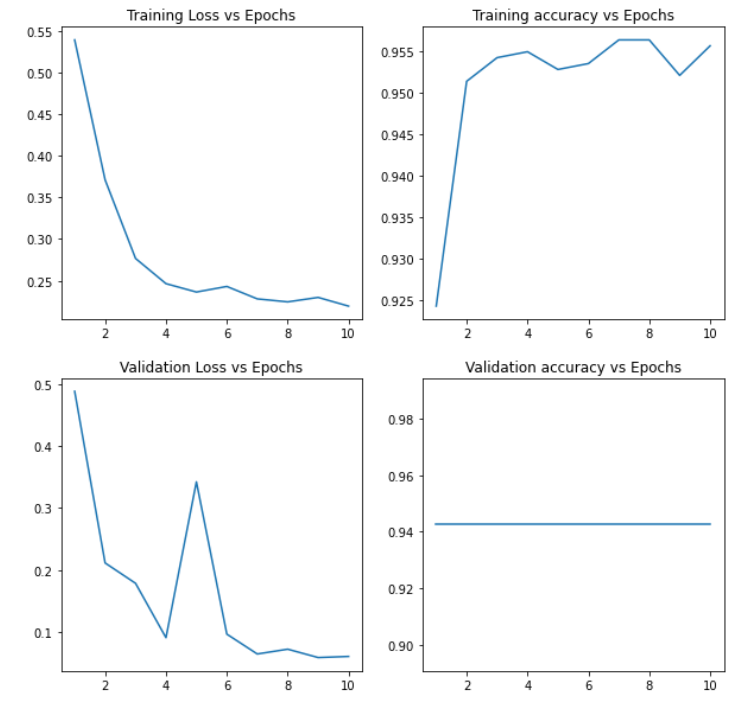
Figure 5. Evaluation of the training and testing accuracy for CNN.